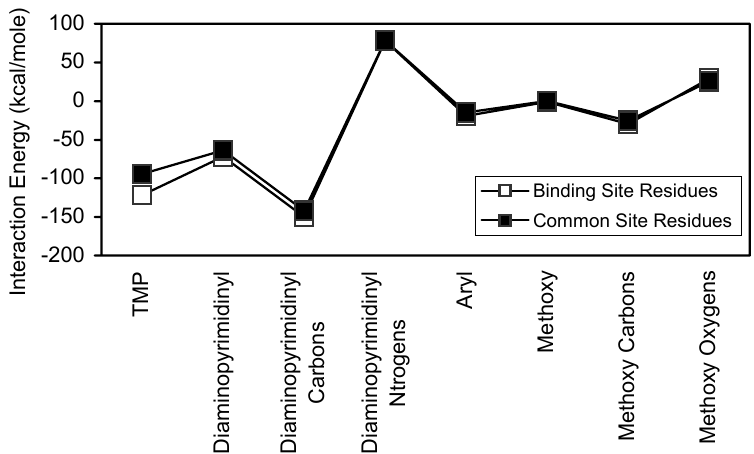
Figure 17 . Comparison of binding site and common site interaction with TMP and its substructural regions.